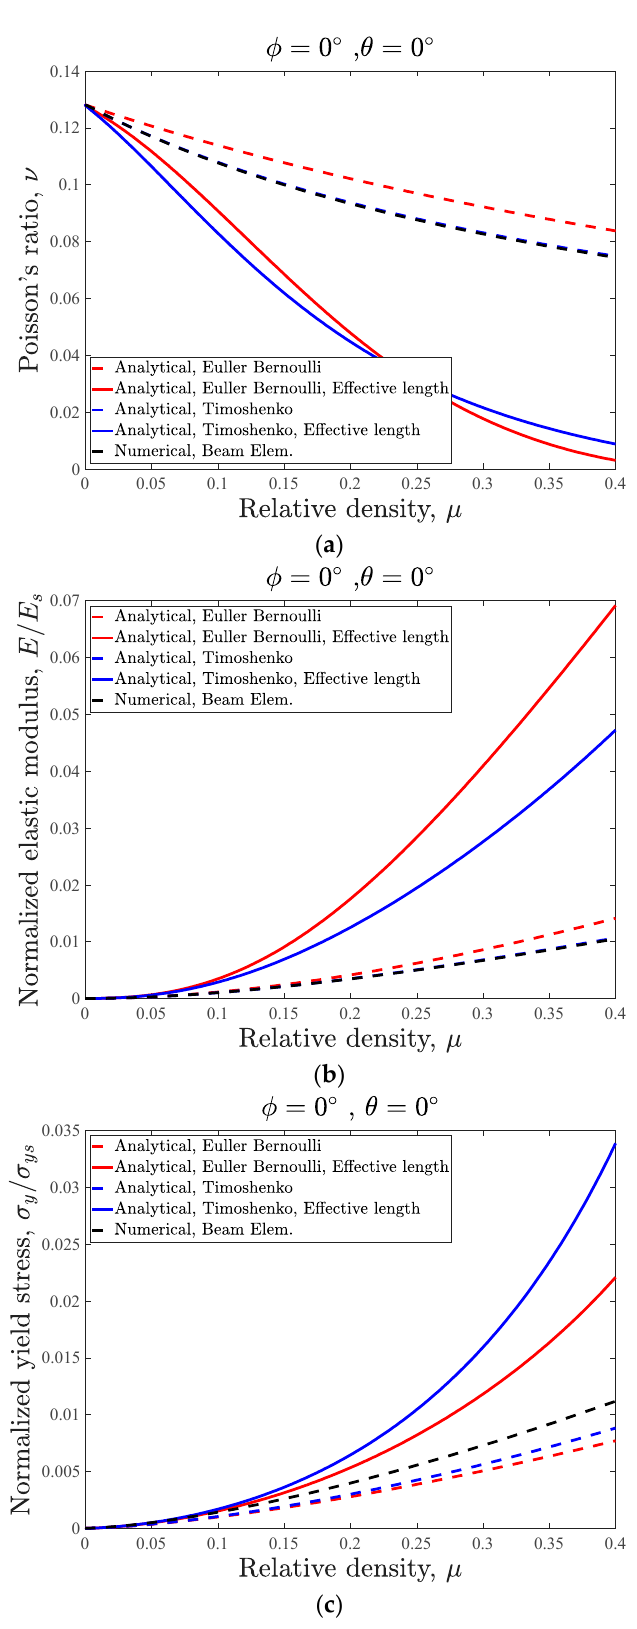
Figure 14. Mechanical properties variations of structure with 𝜑 = 0, 𝜃 = 0 : ( a ) Poisson’s ratio, ( b ) elastic modulus, and ( c ) yield stress.